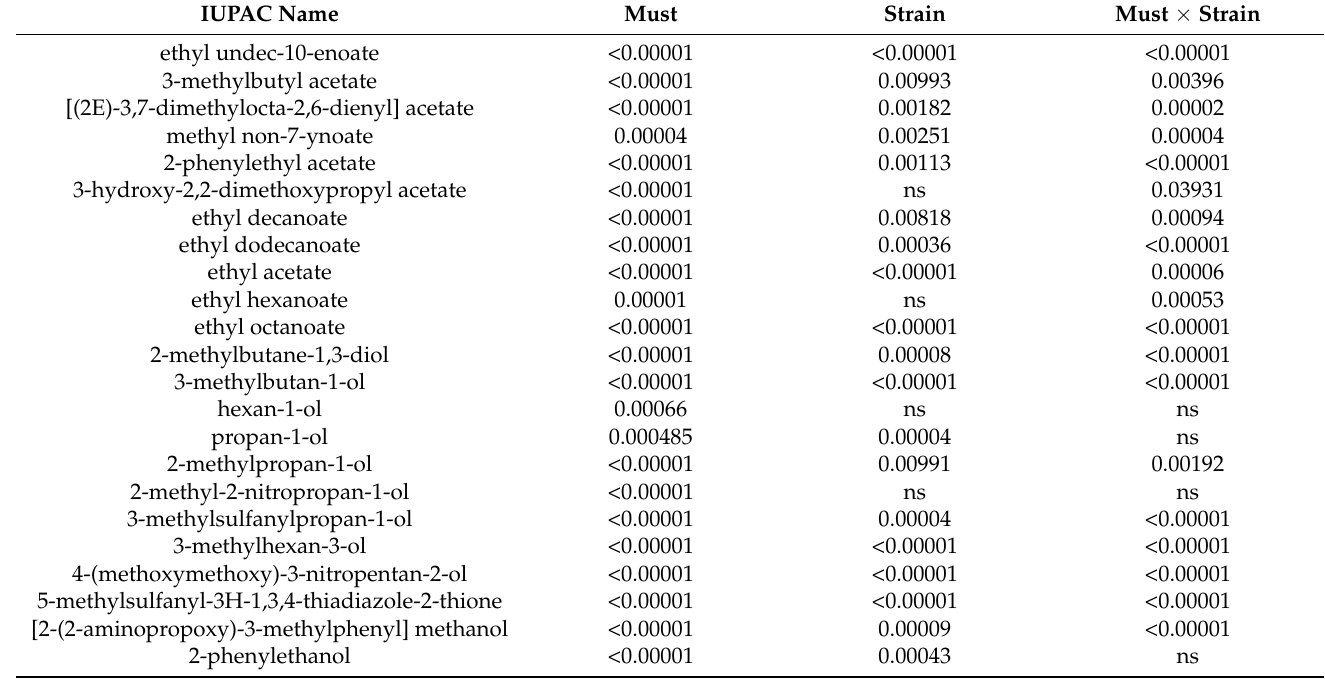
Table 2. Significance ( p -level) of the categorical predictors and their interaction on the amounts of some selected esters and alcohols produced by S. cerevisiae AWRI796 and EC1118 throughout the fermentation of five red grape musts; ns, not significant ( p > 0.05).